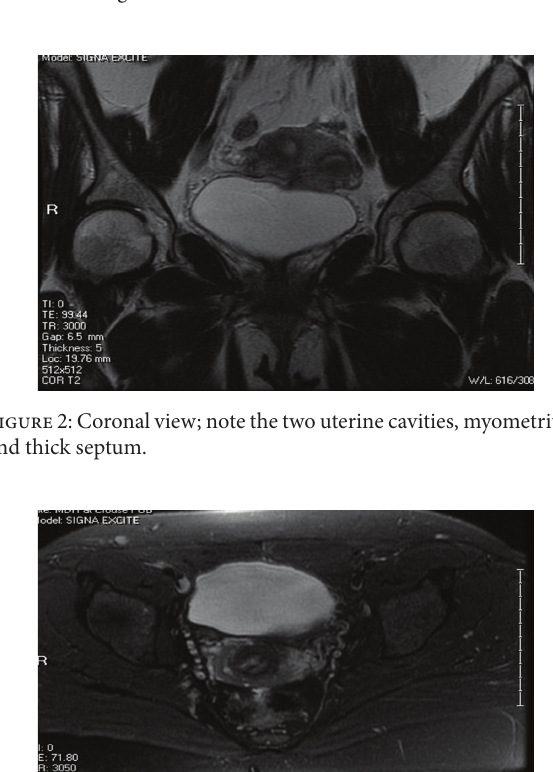
Figure 1: Sagittal view; note the smooth contour of the uterus.